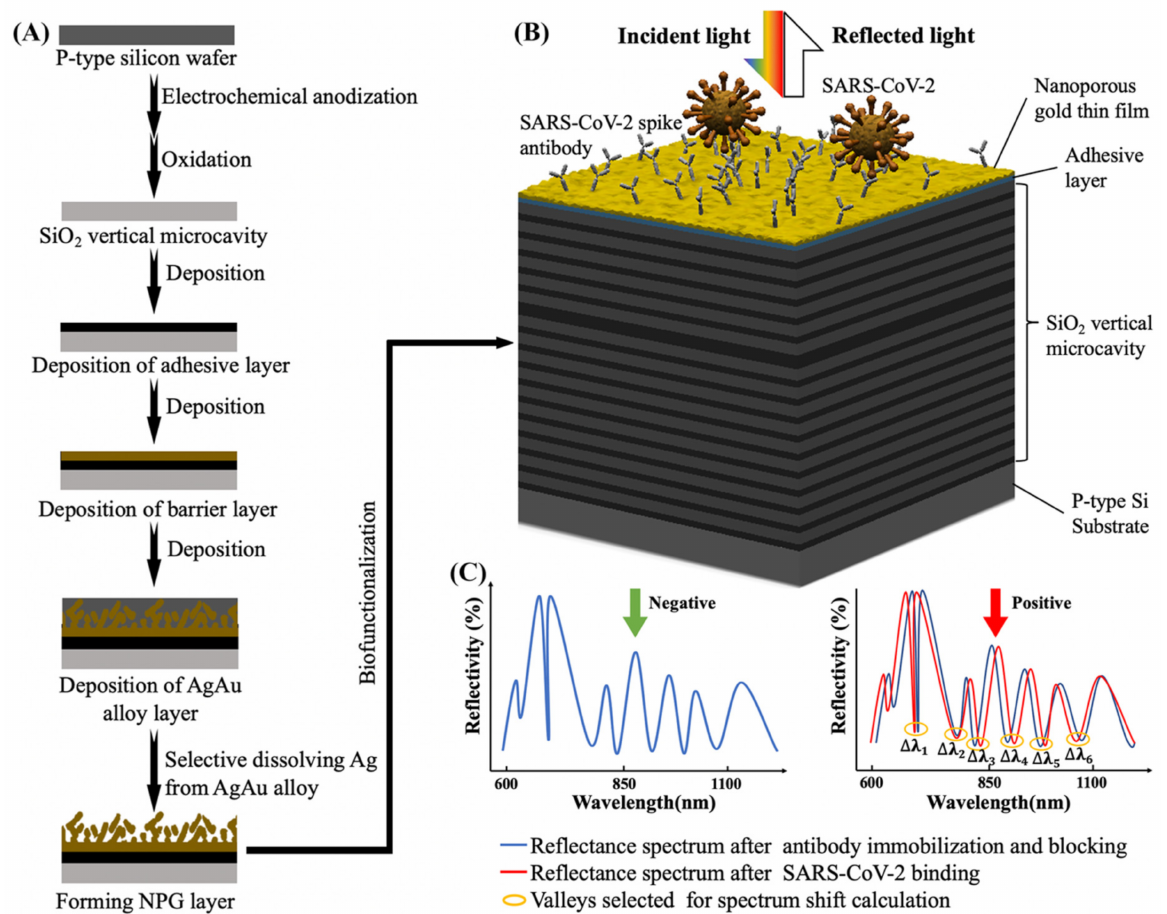
Figure 1. Diagram and detection mechanism of the LSPR- SiO 2 vertical microcavity biosensor: ( A ) the process flow in biosensor fabrication, including the p-type silicon wafer, the SiO 2 vertical microcavity, the adhesive layer deposition, the barrier layer deposition, the Ag-Au alloy thin film deposition and the NPG deposited biosensor die. ( B ) Schematic illustration of the structure of microcavity-LSPR biosensor. The sensor surface is immobilized with SARS-CoV-2 neutralizing antibodies for SARS- CoV-2 capture. ( C ) The optical signal response detection. If the sample contains target virus, a shift in reflectance spectrum will be observed; if no target virus presents, zero shift in the spectrum shift will be